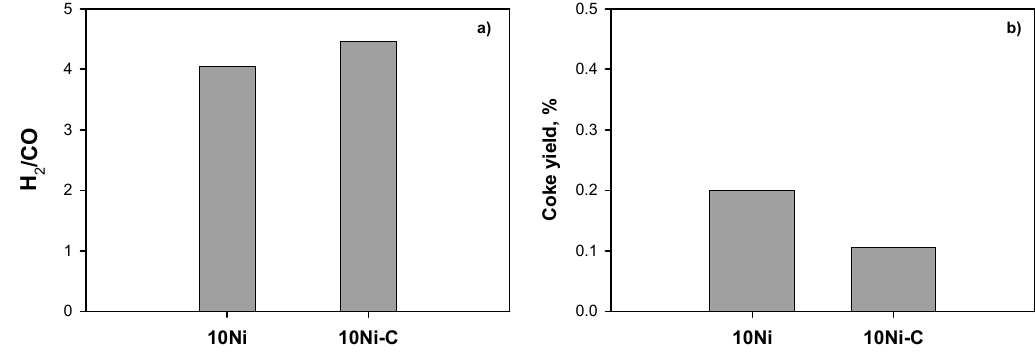
Figure 5. ( a ) H 2 /CO ratio for 10 Ni and 10 Ni-C monoliths during steam reforming of HB mixture at 720 °C and atmospheric pressure; gas-phase feed composition: Solvent/H 2 O/O 2 /N 2 = 0.7/6/0.8/92.5. ( b ) Coke yields for 10 Ni and 10 Ni-C monoliths.